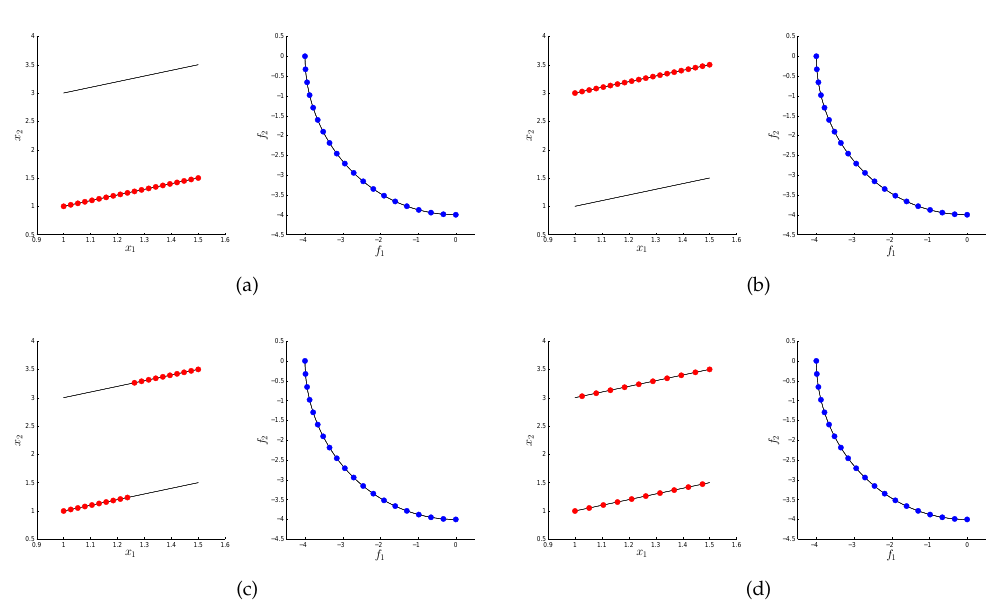
Figure 2. Four different Pareto set/front approximations, where all Pareto front approximations are good (e.g, in the Hausdorff sense), but where only in case ( d ) the Pareto set approximation is